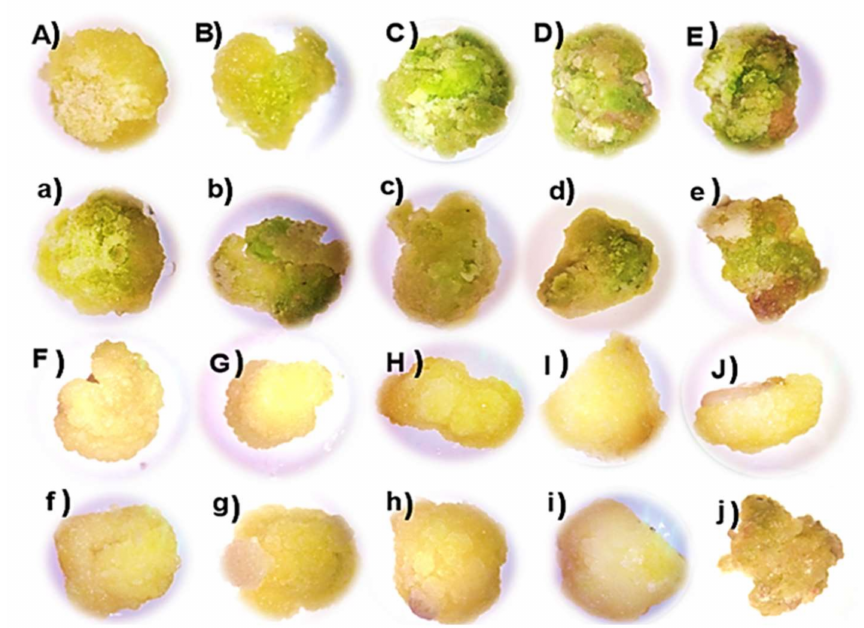
Figure 3. Morphology and phenolization of callus irradiated with UV-B light. ( A ) Callus obtained from leaf explants (control), ( B ) callus obtained from leaf explants with 1 h of irradiation, ( C ) callus obtained from leaf explants with 2 h of irradiation, ( D ) callus obtained from leaf explants with 3 h of irradiation, ( E ) callus obtained from leaf explants with 4 h of irradiation, ( F ) callus obtained from stem explants (control), ( G ) callus obtained from stem explants with 1 h of irradiation, ( H ) callus obtained from stem explants with 2 h of irradiation, ( I ) callus obtained from stem explants with 3 h of irradiation, ( J ) callus obtained from stem explants with 4 h of irradiation. Capital letters are for calluses with two weeks of exposure and lowercase letters with four weeks of